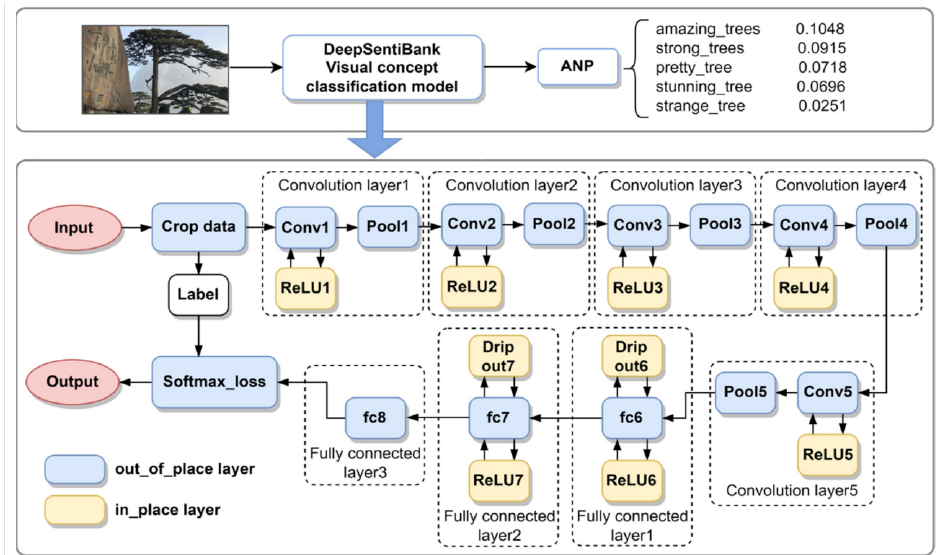
Figure 3. DeepSentiBank model with convolutional neural network